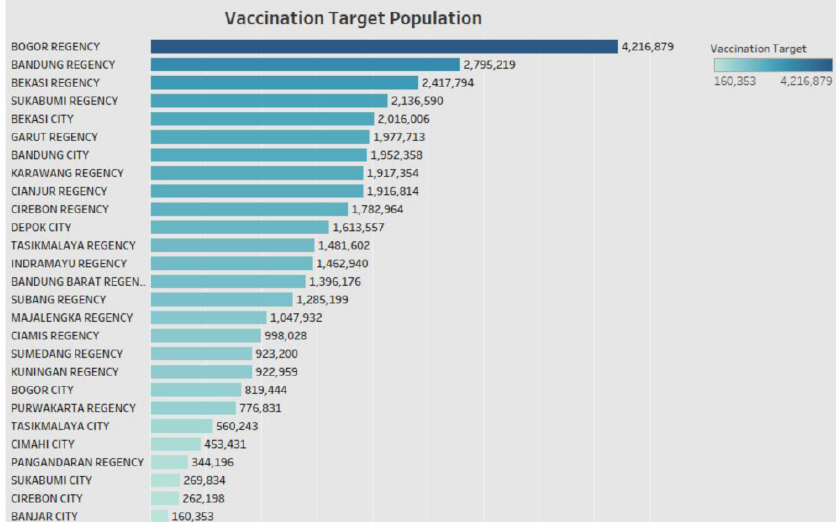
Figure A1. The population size of vaccination targets in each city and regency as of November